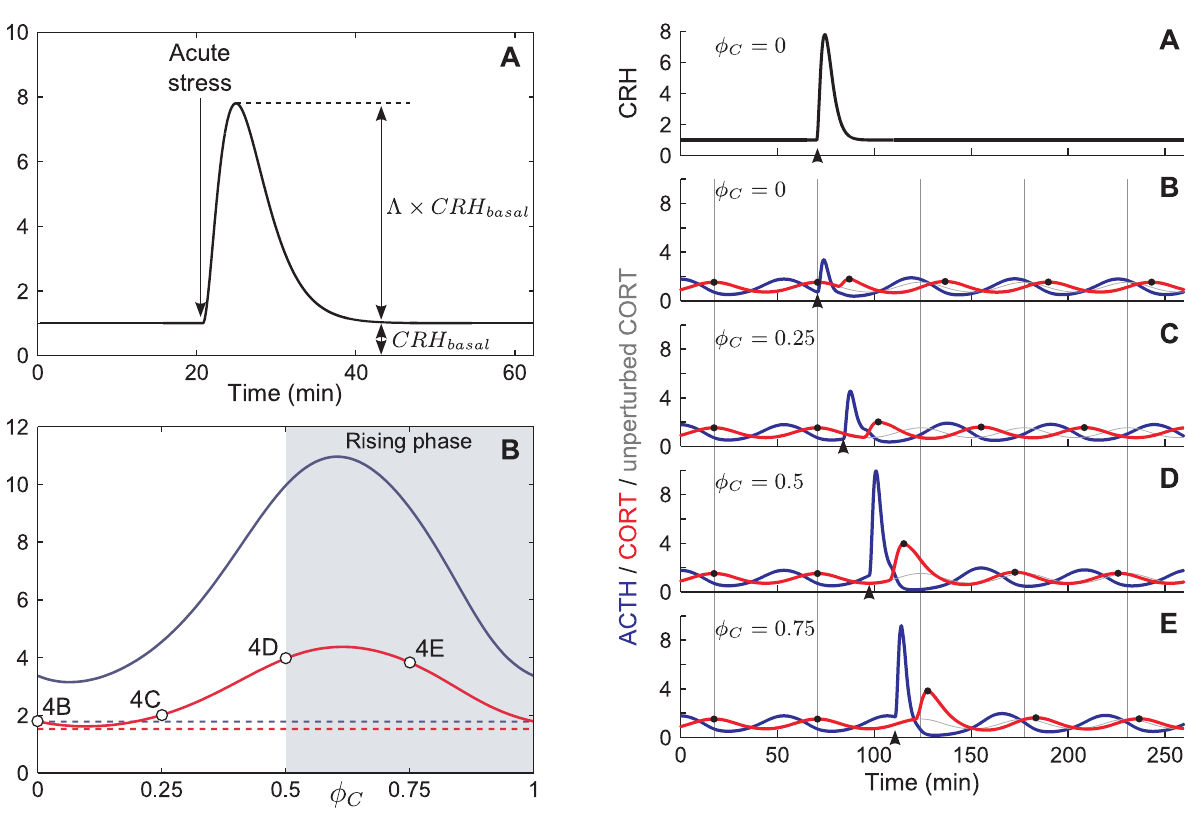
Figure 3. Timing of CRH-impulse determines magnitude of CORT response. (A) Profile of CRH-impulse where the amplitude L is scaled by the basal level of CRH. (B) Amplitude response curves of ACTH (solid blue) and CORT (solid red) computed for L ~ 6 : 8 with varying phase w C of the CRH impulse ( w C ~ 0 corresponds to the peak of the CORT pulse). As a reference, the maximum levels of basal oscillations in ACTH (dashed blue) and CORT (dashed red) are also plotted. The shaded region indicates values of w C that correspond to the rising phase of the CORT oscillation. Markers on the CORT amplitude response curve correspond to the time histories plotted in Figure 4B–E.